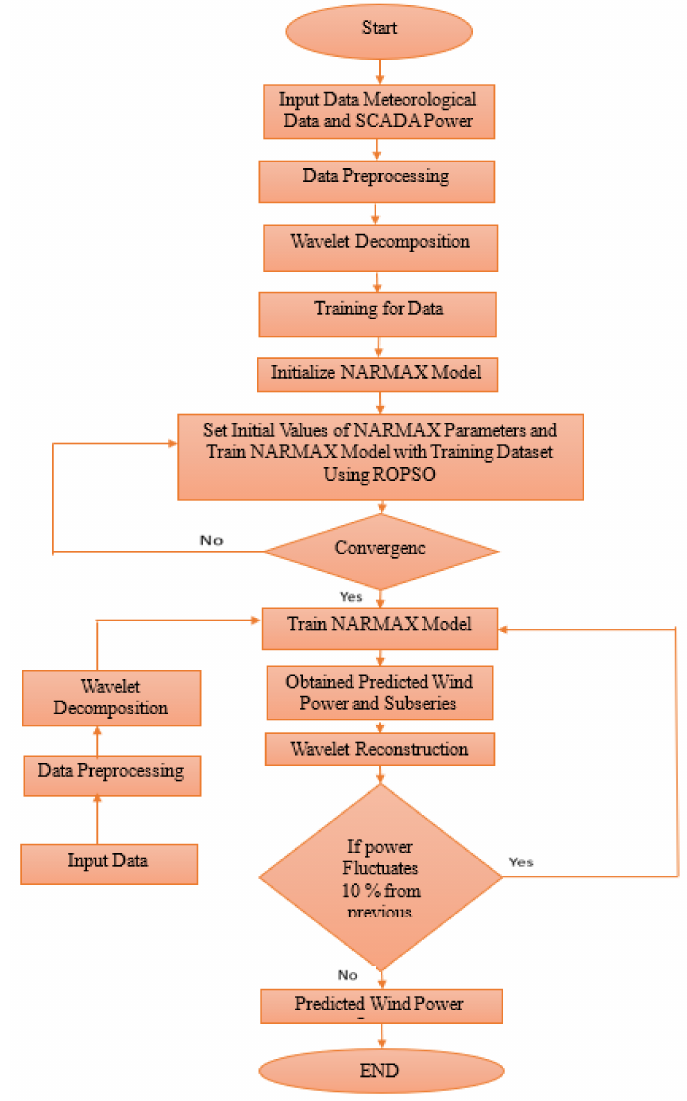
Figure 4. Flow chart of the proposed prediction